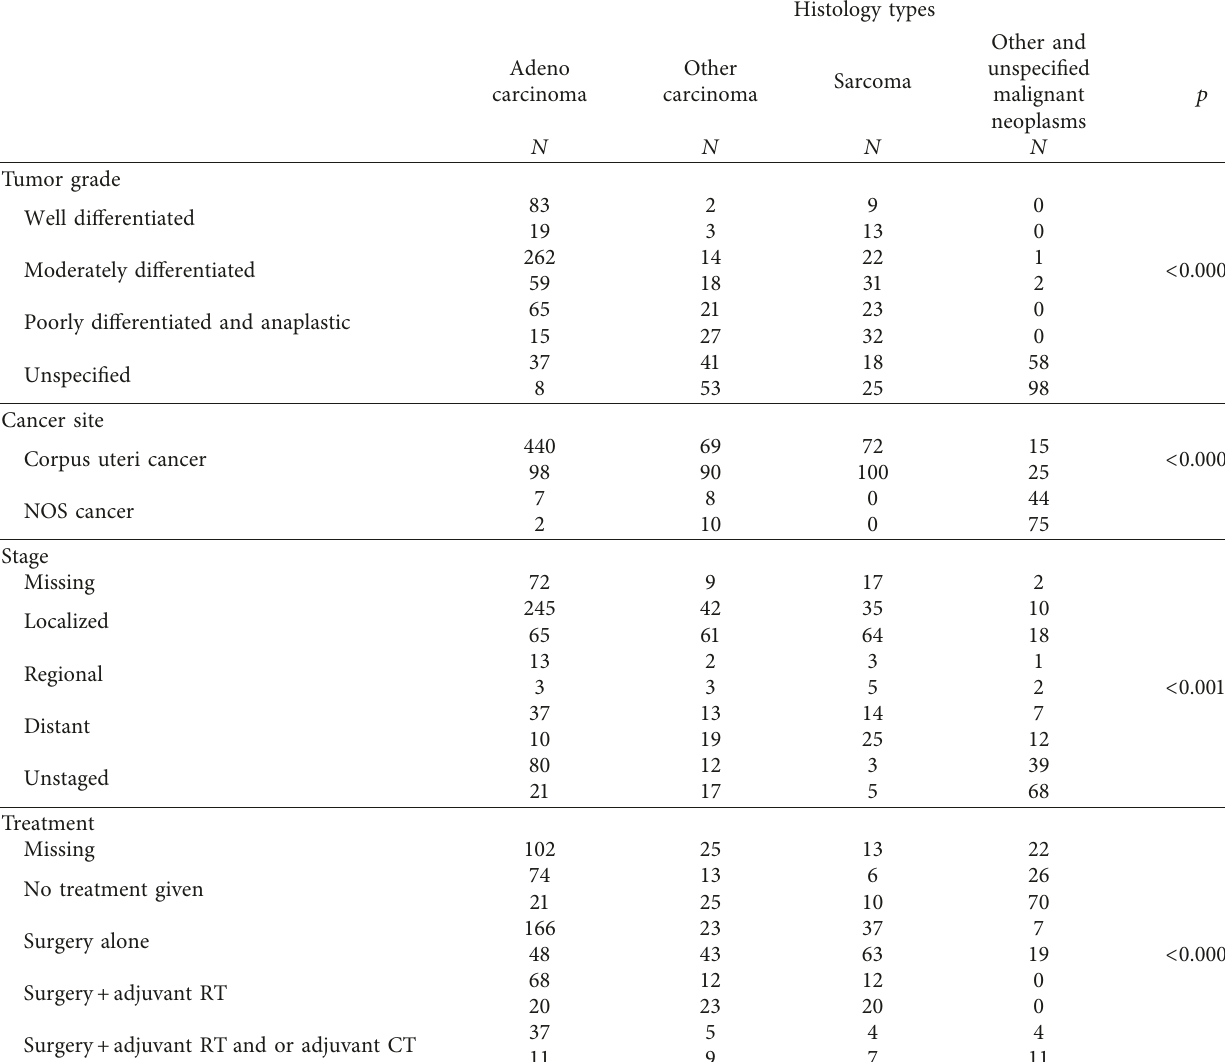
Table 5: The association of histology types of cancer and different clinical characteristics ( n � 660) in the Gharbiah province,